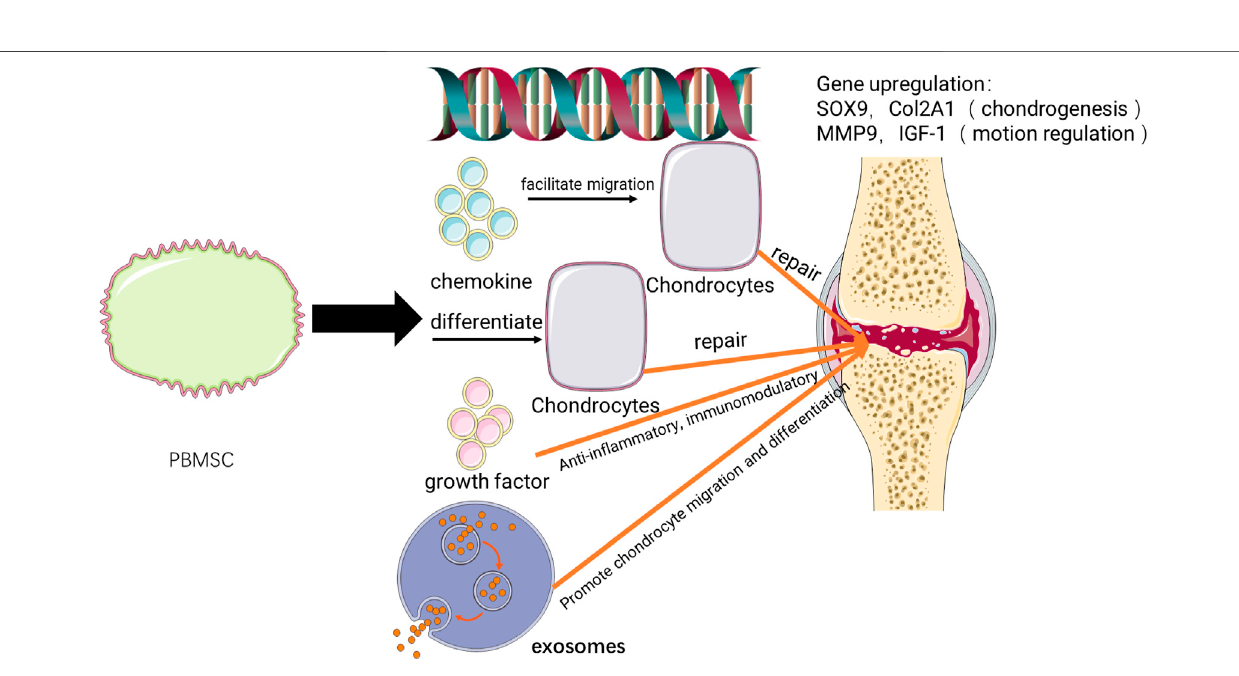
FIGURE 6 | Potential mechanisms of PBMSC in cartilage